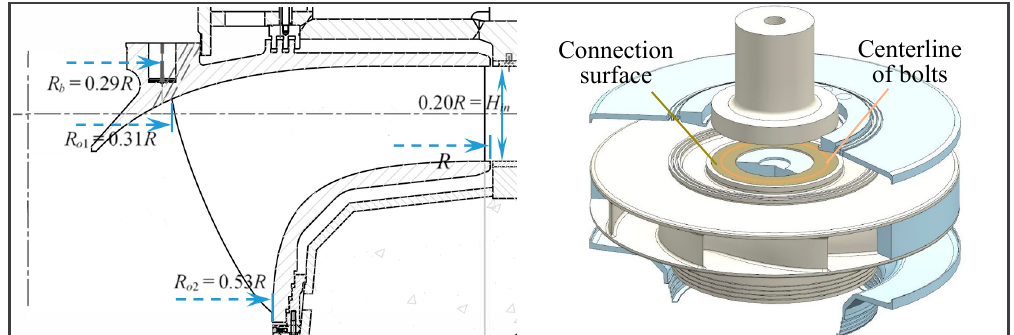
Figure 1. Schematic diagram of the runner and surrounding